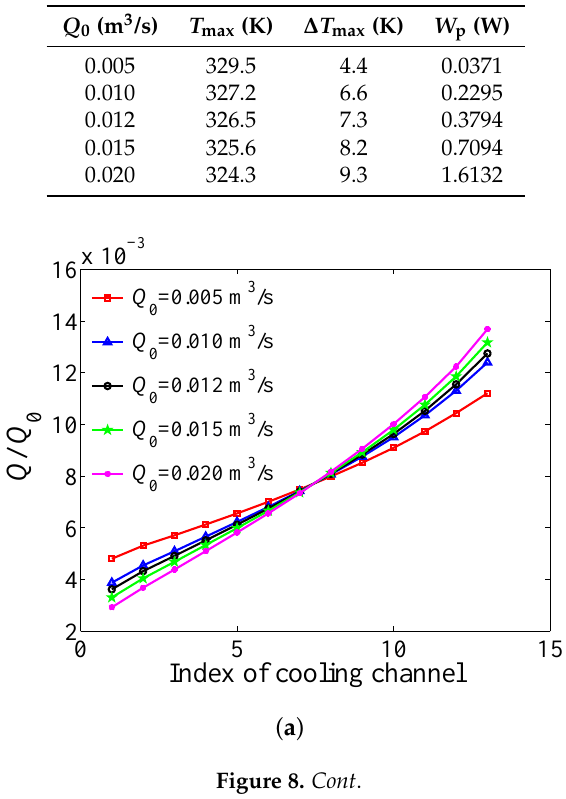
Table 6. Numerical results for various inlet airflow